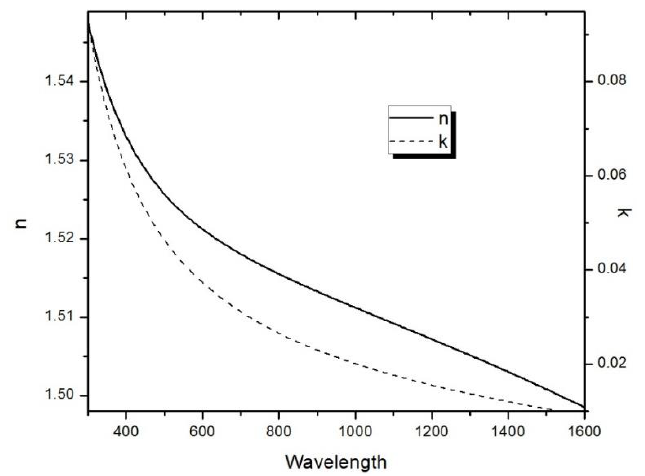
Figure 2. Refractive index (solid line) and extinction coefficient (dashed line) of the sample extracted from ellipsometric measures.